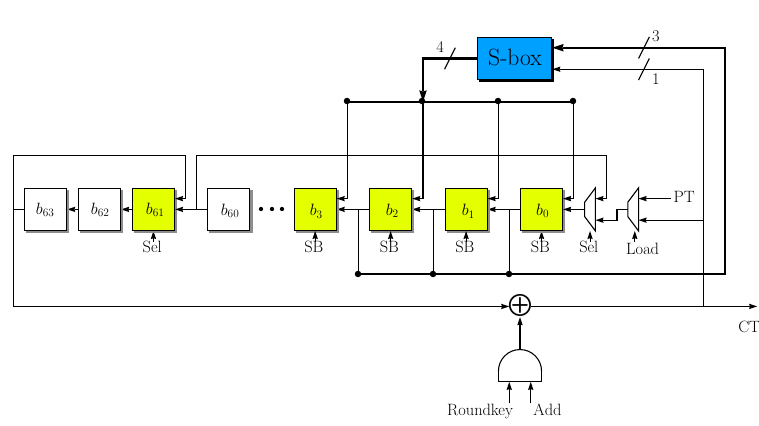
Figure 3: The PRESENT datapath